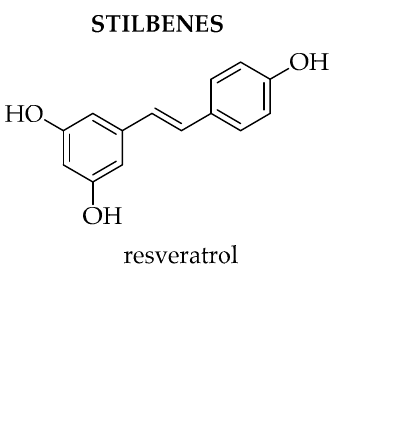
Figure 2. Stilbenes and lignans.